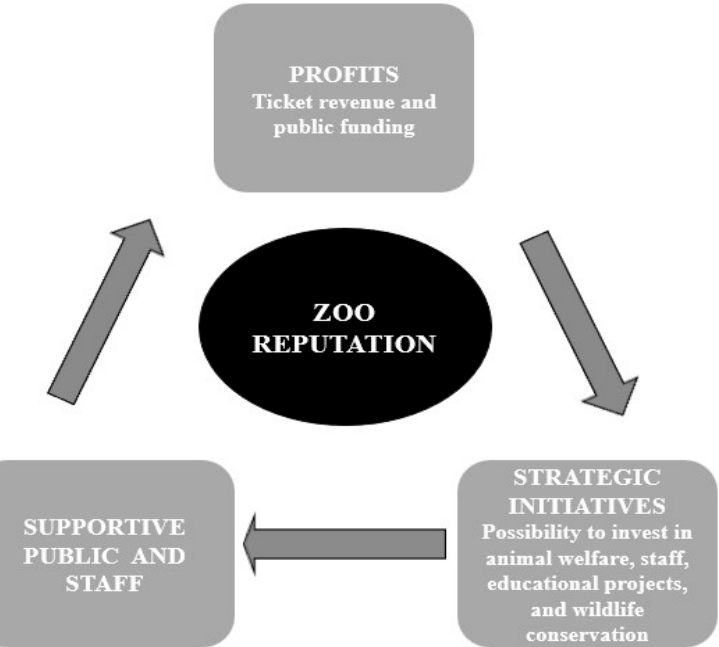
Figure 1. The reputational value cycle of zoos. A good zoo reputation can act as a positive reinforce- ment loop engine. It will ensure supportive public and staff, attract more visitors and revenue, and provide access to public funding. These will allow investment in strategic initiatives (animal welfare, staff, educational projects, and wildlife conservation), enabling the zoo to act according to its mission.